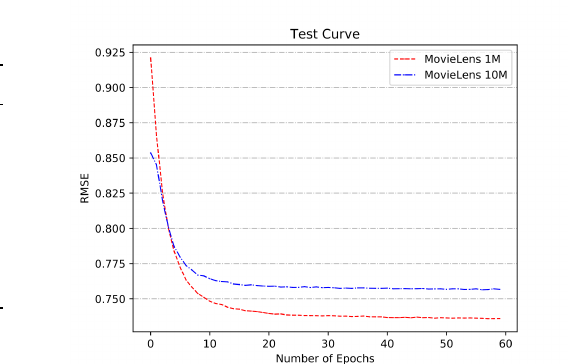
Figure 4. ( Left ) A table about Test Root Mean Square Error (RMSE) on two datasets. ( Right ) A picture about two corresponding curves of ACAE on RMSE values.